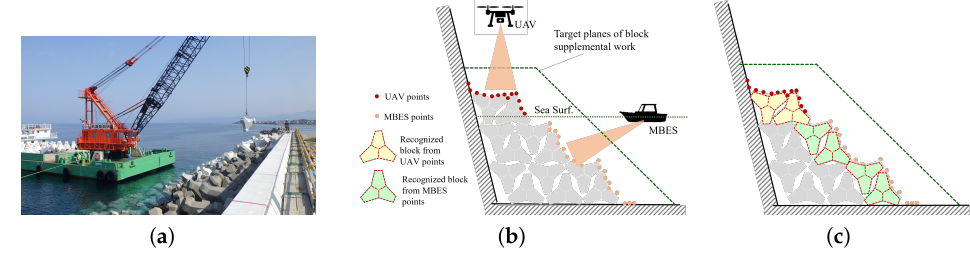
Figure 1. Supplemental work on wave-dissipating blocks. Periodical repair work aims at stacking new supplemental blocks on top of existing ones until the target height. ( a ) Block supplemental work; ( b ) Three-dimensional (3D) measurement of existing block surface; ( c ) Individual block pose